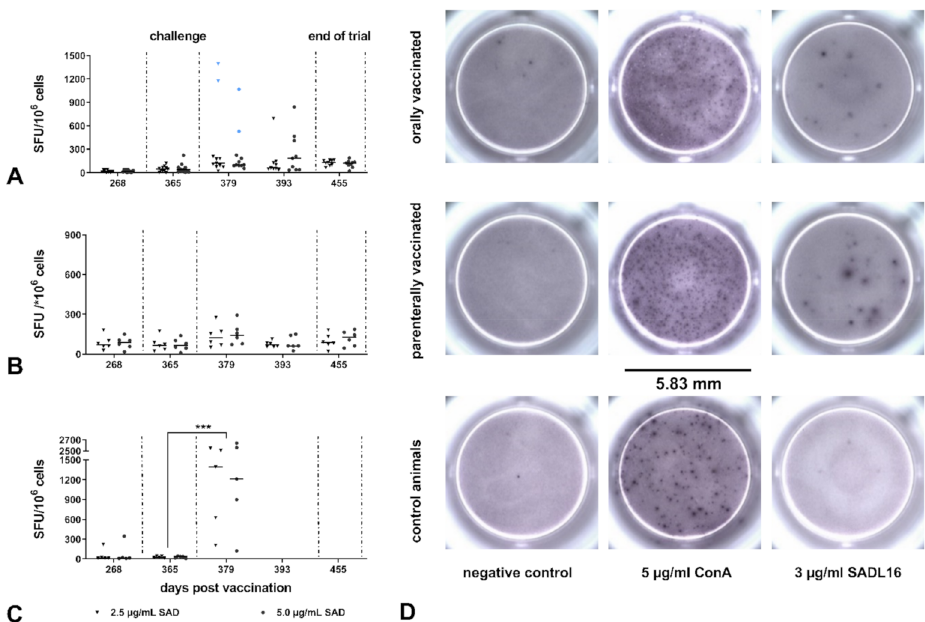
Figure 5. T-cell specific IFN- γ production of PBMCs from foxes after rabies vaccination and challenge infection: ( A ) orally vaccinated foxes; ( B ): parenterally vaccinated foxes; ( C ) non-vaccinated controls. Data are depicted as IFN- γ SFU of PBMCs from individual foxes in response to stimulation with 2.5 µ g/mL (triangles) and 5.0 µ g/mL (dots) of RABV antigen (SAD L16) and mean (horizontal line) for each time point and group. Seronegative foxes (No ◦ 34 and 41) in the orally vaccinated group are shown in blue. Statistically significant differences between consecutive sampling time points within groups are denoted as follows: *** p ≤ 0.001. The vertical dotted lines indicate the time point of challenge (365 dpv) and the study’s termination (455 dpv). ( D ) Representative images of cavities showing IFN- γ SFU of ConA and RABV antigen-stimulated fox PBMCs for vaccinated and control